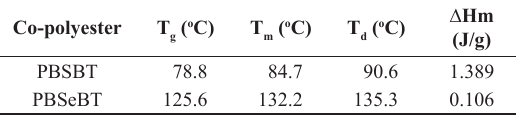
Table.1: Thermal properties of the synthesized copolyesters Co-polyester